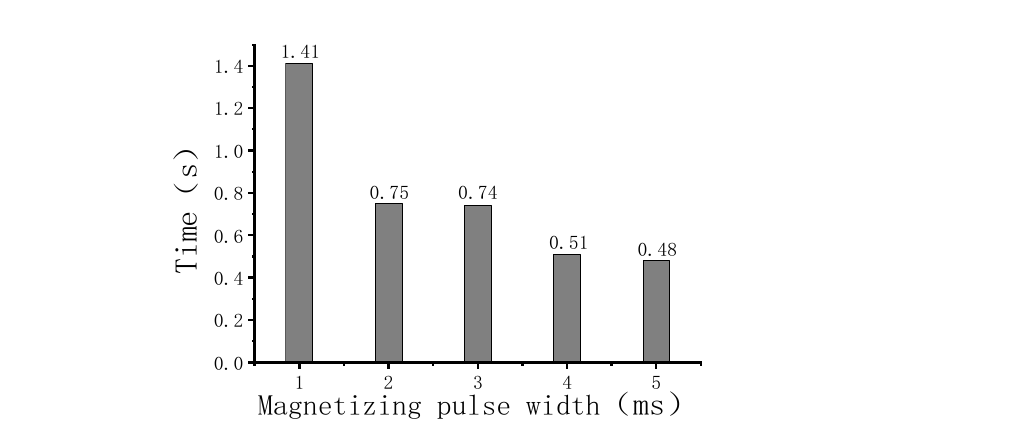
Figure 18. Correspondence curves for different magnetization pulse widths and cold-start times.